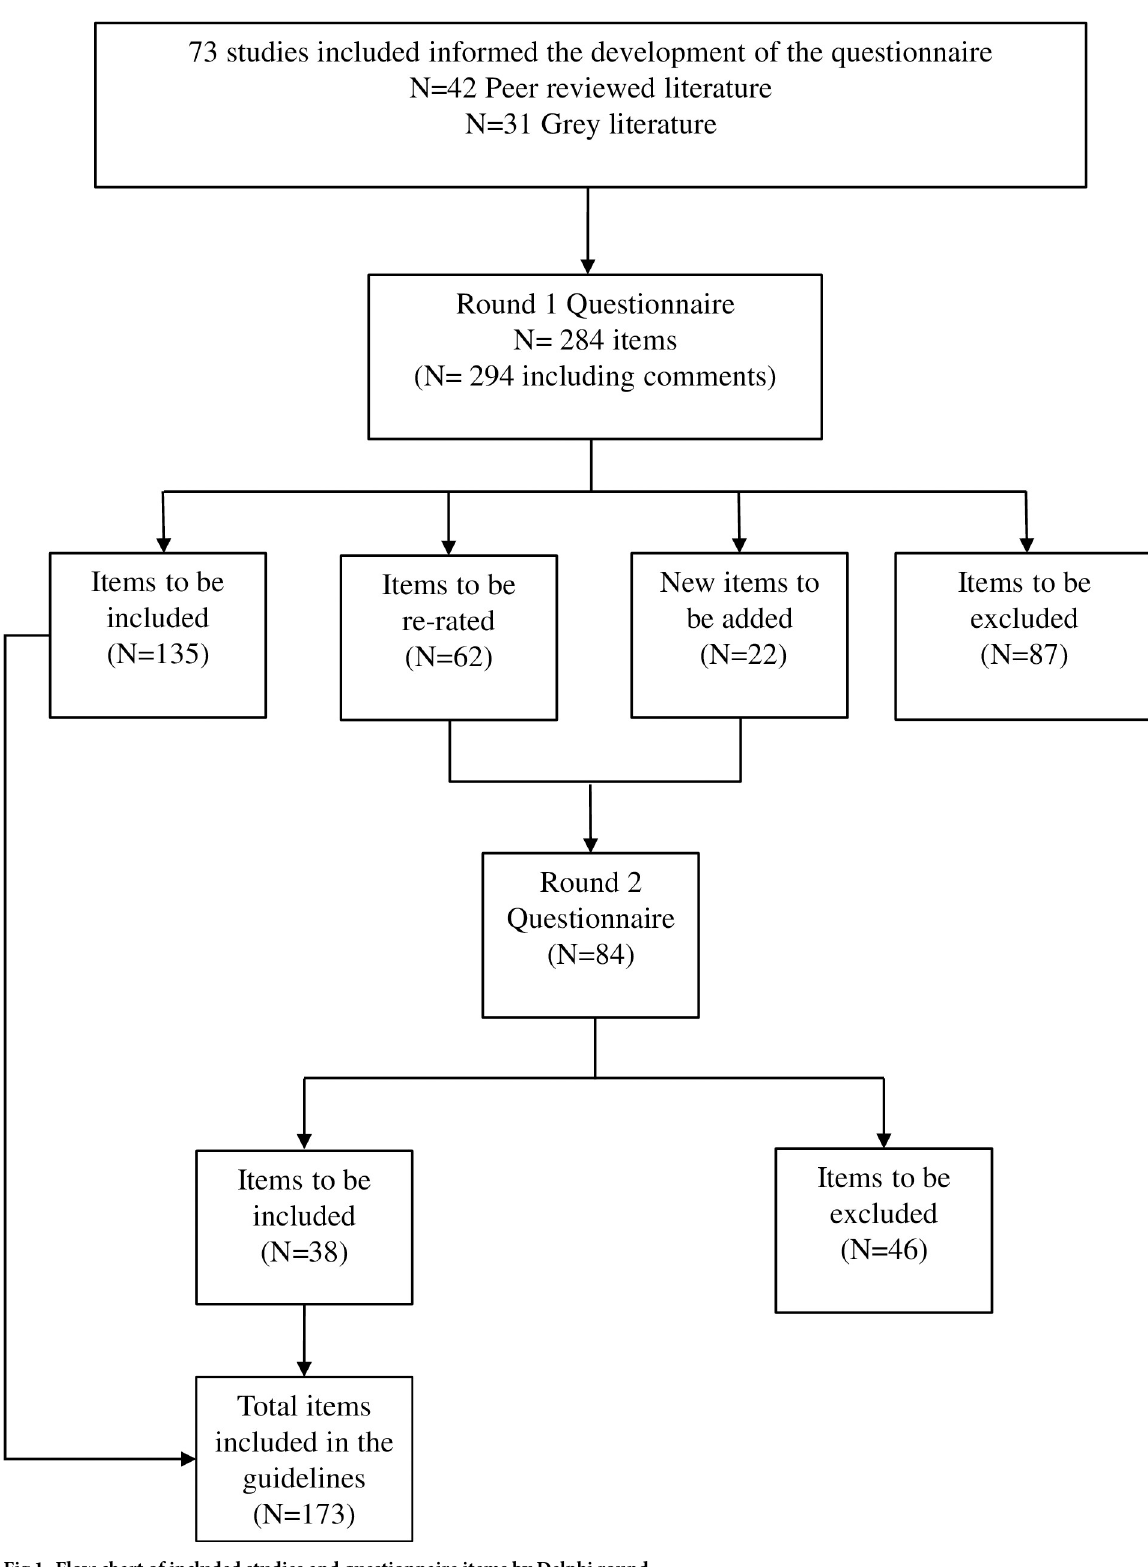
Fig 1. Flow chart of included studies and questionnaire items by Delphi round.